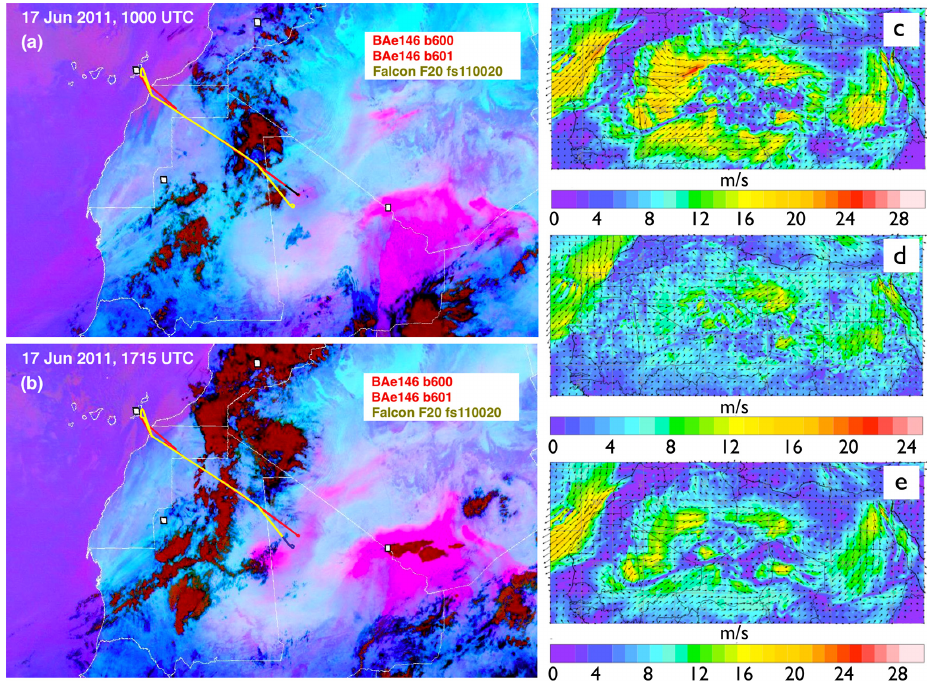
Figure 13. (a) and (b) SEVIRI RGB dust imagery for 10:00 and 17:00UTC, and showing the flight tracks of flight b600 and b601 respectively (BAe146 track in red, F20 track in yellow, black track sections show location of aircraft at satellite image time. (c) , (d) and (e) UK Met Office wind forecasts for 06:00UTC at 925hPa (c) , 06:00UTC at 10m (d) and 09:00UTC for 925hPa (e) , all for 17 June 2011 on the morning of the flight.